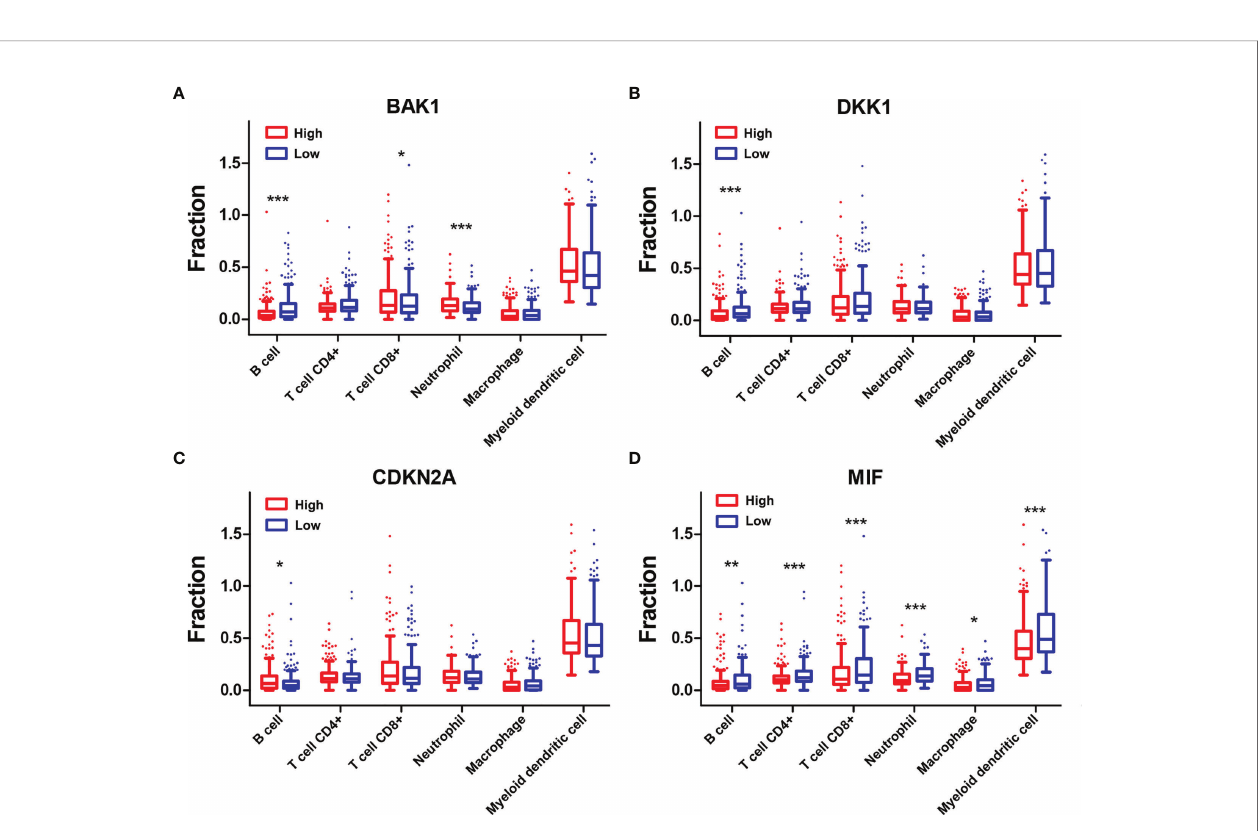
FIGURE 8 | Association of six types of immune cells with the four selected AGs. (A – D) Comparison of six types of immune cells according to BAK1 (A) , DKK1 (B) , CDKN2A (C) , and MIF (D) expression levels. * p < 0.05, ** p < 0.01, and *** p <